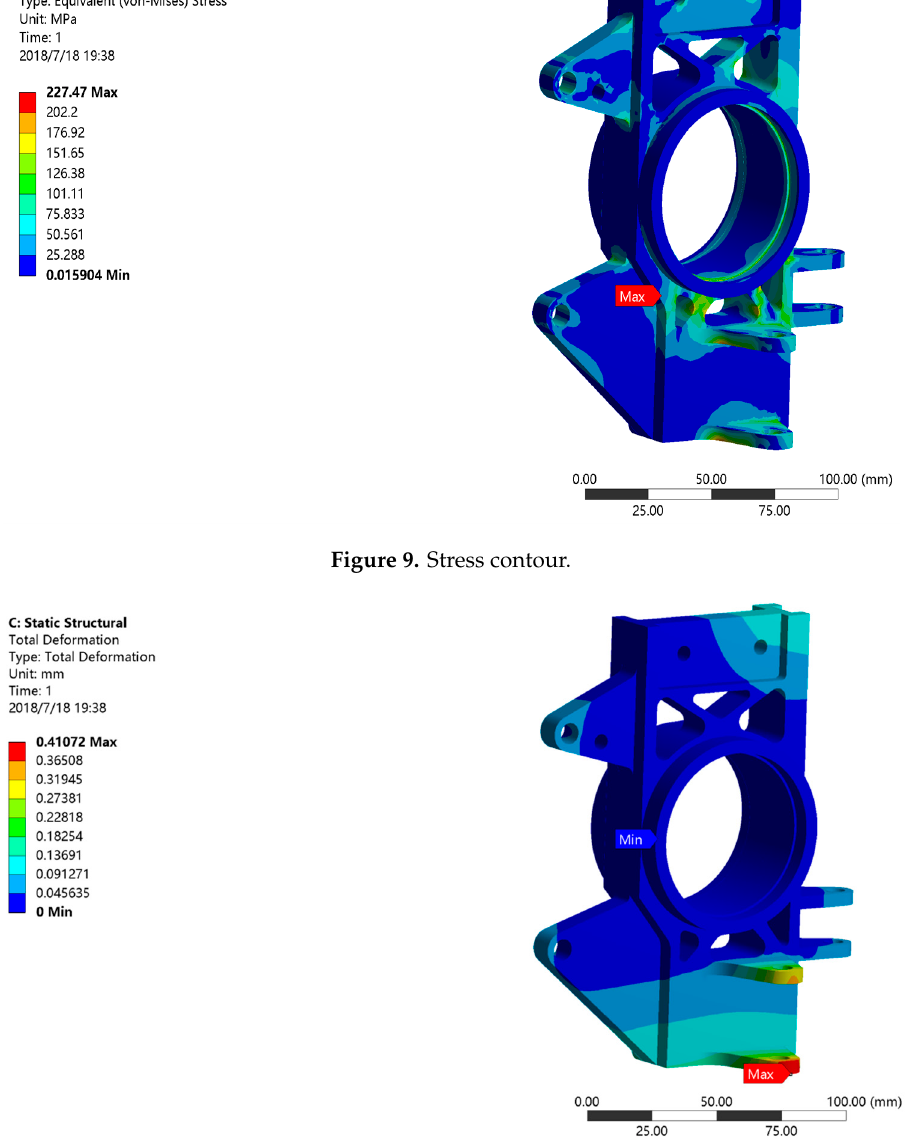
Figure 10. Strain cloud. Figure 10. Deformation